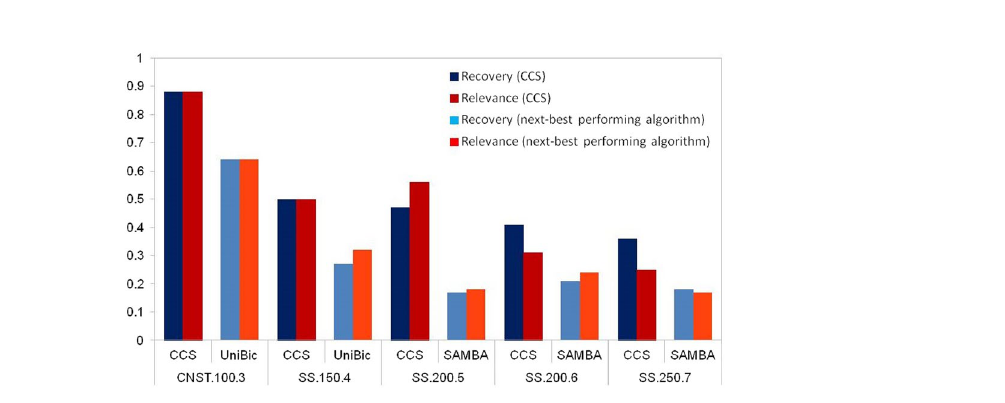
Figure 1. Recovery and Relevance scores on five synthetic datasets for CCS and the next-best performing